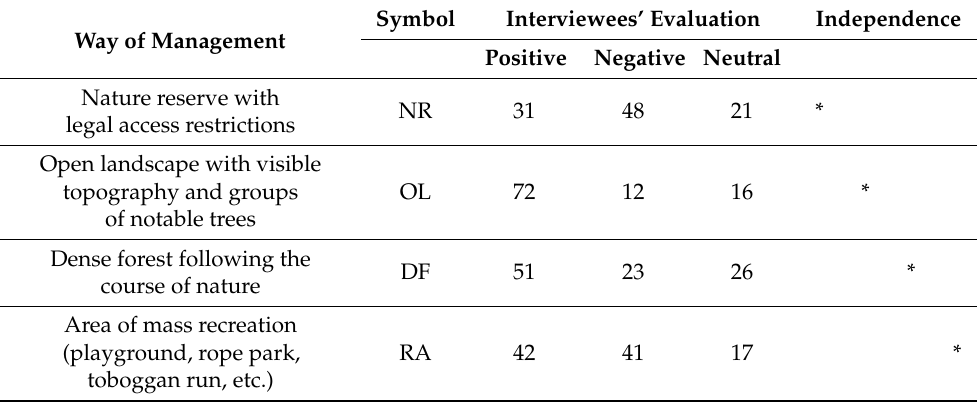
Table 2. The visitors’ (inclusive) preferences with regard to Lisia G ó ra conservation/management descriptive scenarios and possible accessibility solutions. NR—nature reserve, OL—(semi)open landscape, DF—dense forest following natural dynamics, RA—recreation area; asterisks in different columns indicate significantly differing proportions, Chi-square for independence, p < 0.05. Symbol Interviewees’ Evaluation Independence Way of Management Positive Negative Neutral Nature reserve